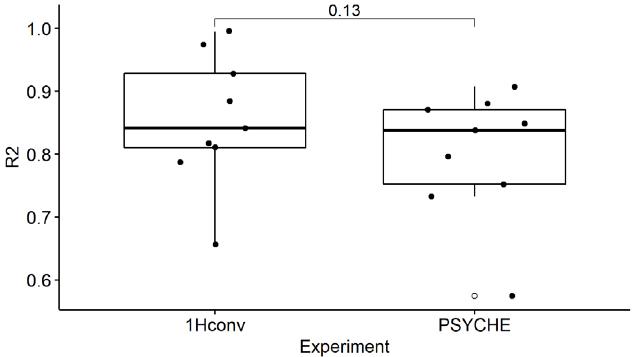
Figure 6. Boxplot of the coefficient of determination (R 2 , Table 1) for the conventional 1 H-NMR (1Hconv) and the PSYCHE experiment with a bin size of 0.02 ppm. Significance Test: Wilcoxon–Mann–Whitney paired (shown is p -value).